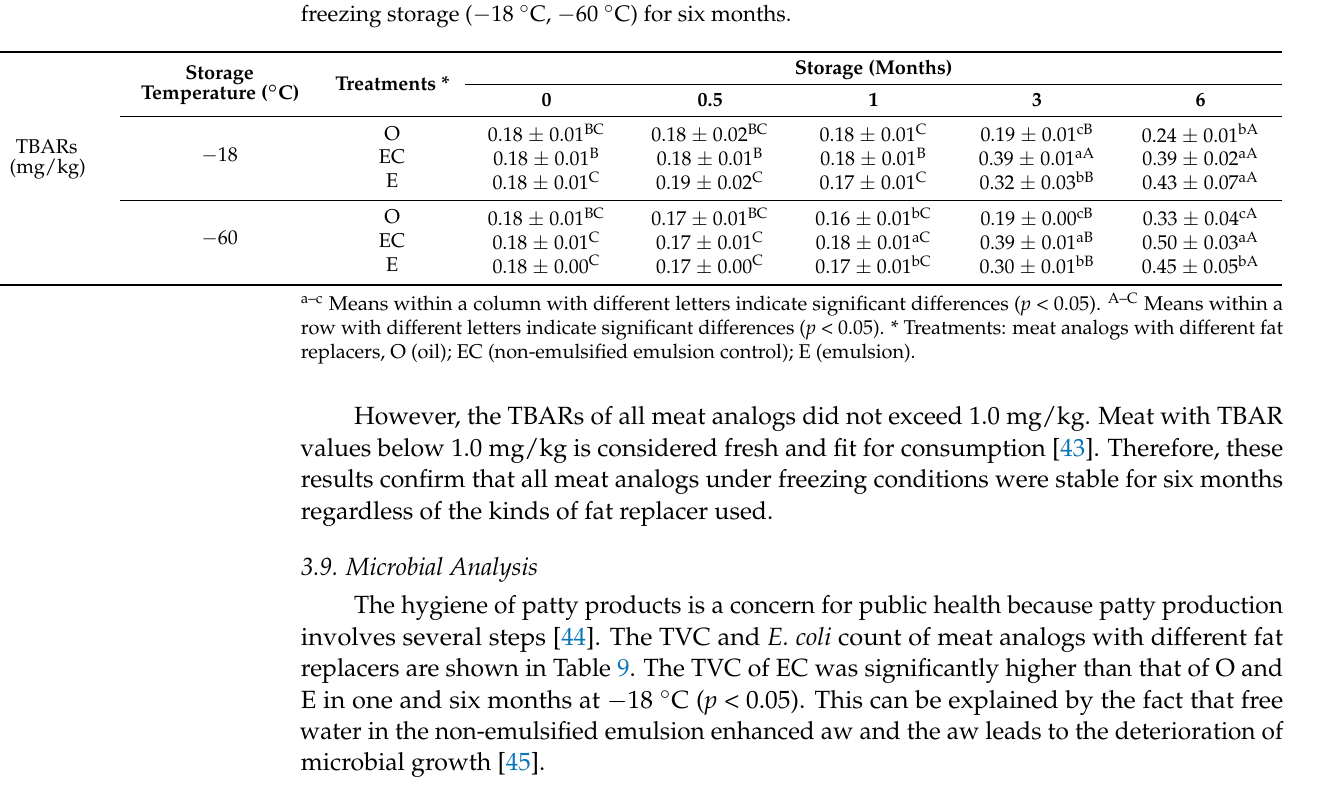
Table 9. Total viable counts and Escherichia coli count (log CFU/mL) of meat analogs with different fat replacers (O, EC, and E) during the freezing storage ( − 18 ◦ C, and − 60 ◦ C) for six